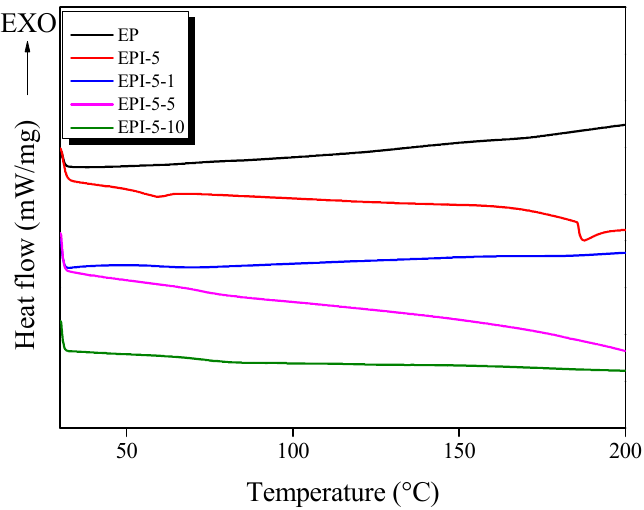
Figure 2. DSC thermograms of postcured epoxy/polyimide blends analyzed in N 2 gas atmosphere. Table 1. DSC parameters of postcured epoxy/polyimide blends analyzed in N 2 gas atmosphere.